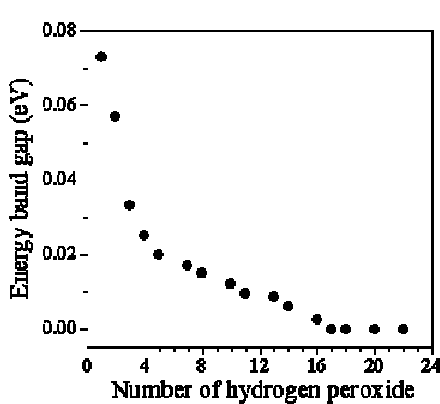
Fig. 6. Energy band gap of defective graphene via number of hydrogen peroxide per